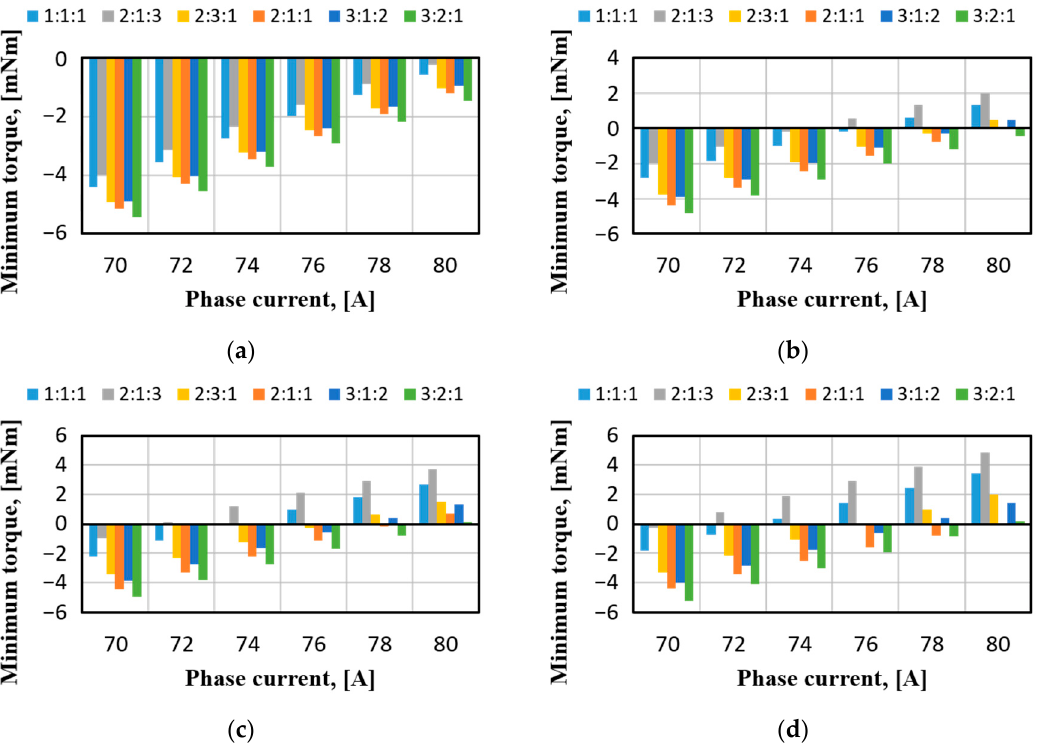
Figure 7. Minimum torque of stepped air gap with respect to DC current and angle ratio: ( a ) 1.25; ( b ) 1.50; ( c ) 1.75; ( d ) 2.00.